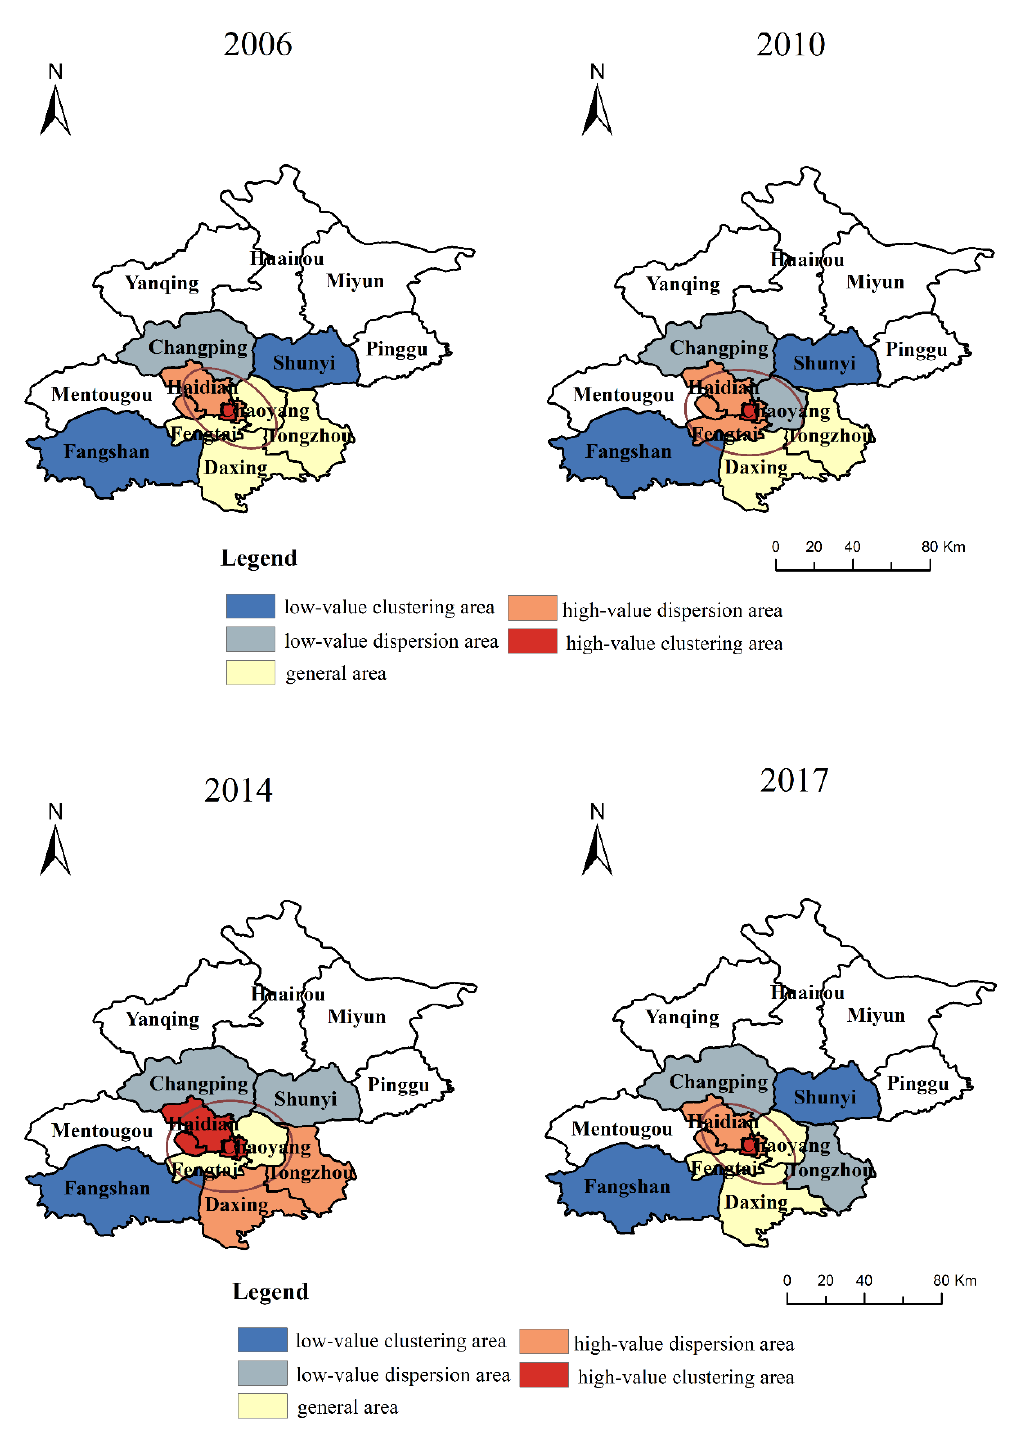
Figure 5. The spatiotemporal distribution of high–low value clustering points with different overall coupling coordination degrees.